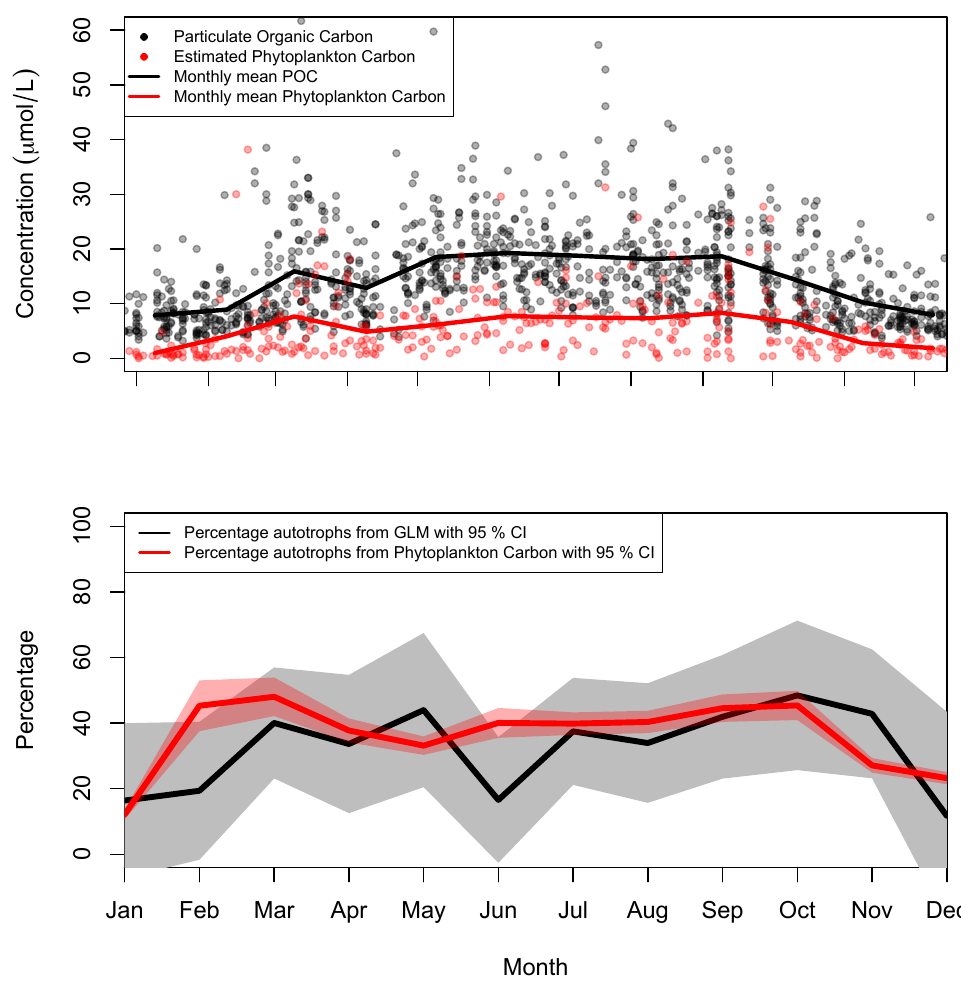
Fig. 8. Upper panel shows the seasonal concentrations of POC and phytoplankton C in µmoll − 1 , while the lower panel shows the independent estimates of autotrophic percentage from phytoplankton C and the regression